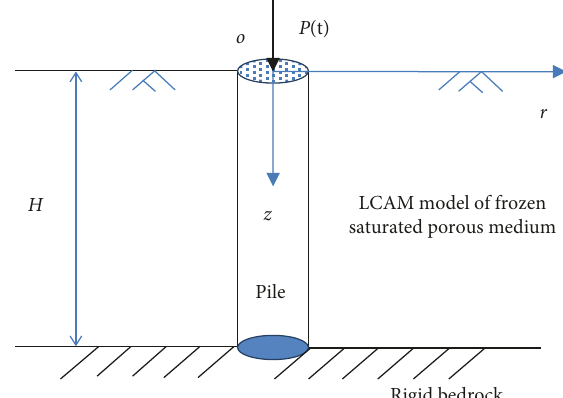
Figure 2: Schematic of dynamic interaction between pile and frozen